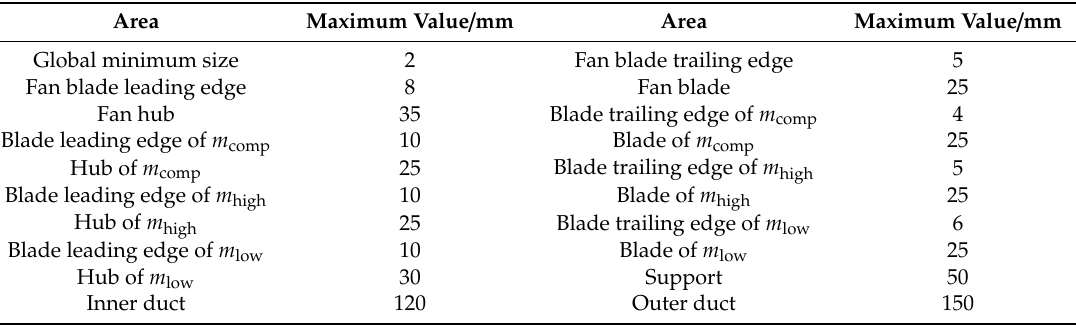
Table 3. Grid size for each part of the turbofan